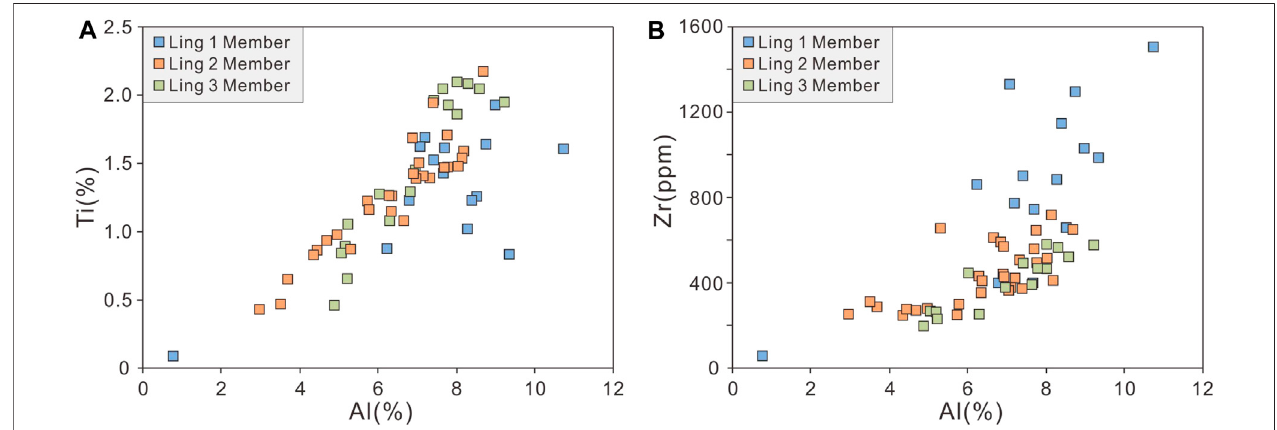
FIGURE 9 | (A) Crossplot of Ti-Al for Linghao Formation marine shale. (B) Crossplots of Zr-Al for Linghao Formation marine shale.